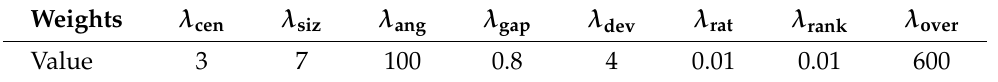
Table 5. Cell tracking accuracy for the short image sequence COL2 in Figure 6 with an interframe of six minutes. We report the ratio of correctly predicted cell matches over the total number of true cell matches and the associated percentages. The accuracy results quantify four distinct percentages of correct detections (i) for parent cells in image J , (ii) for children cells in image J + , (iii) for parent– children triplets, and (iv) for registered pairs of cells ( b , b + )